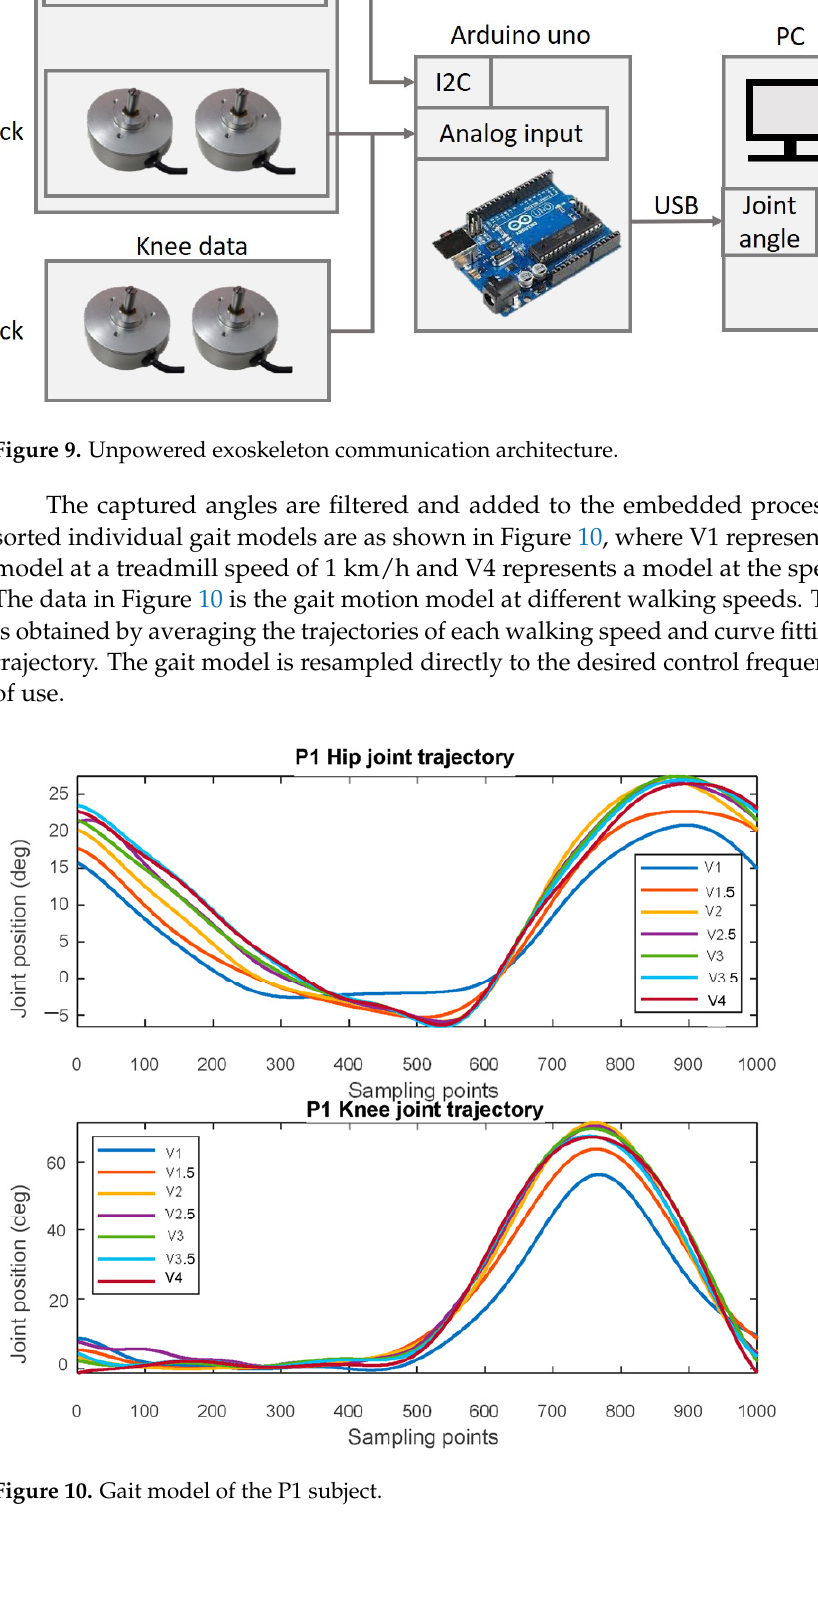
Figure 10. Gait model of the P1 subject.